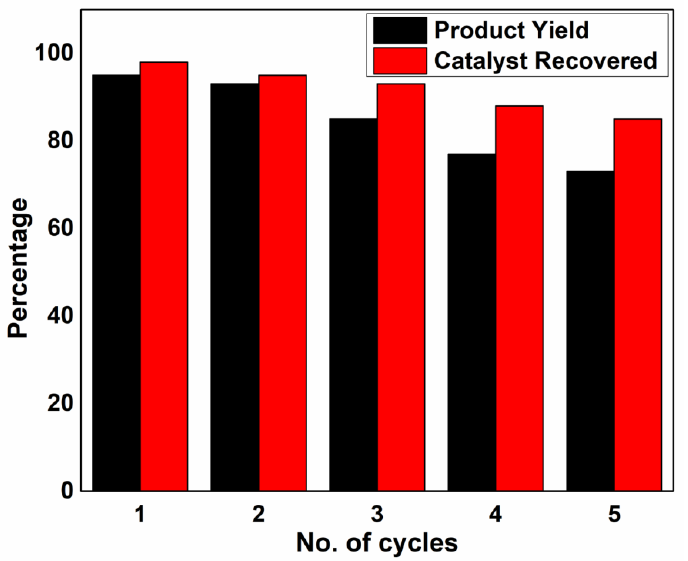
Figure 7. Recyclability test of Ru ‐ GCN catalyst.